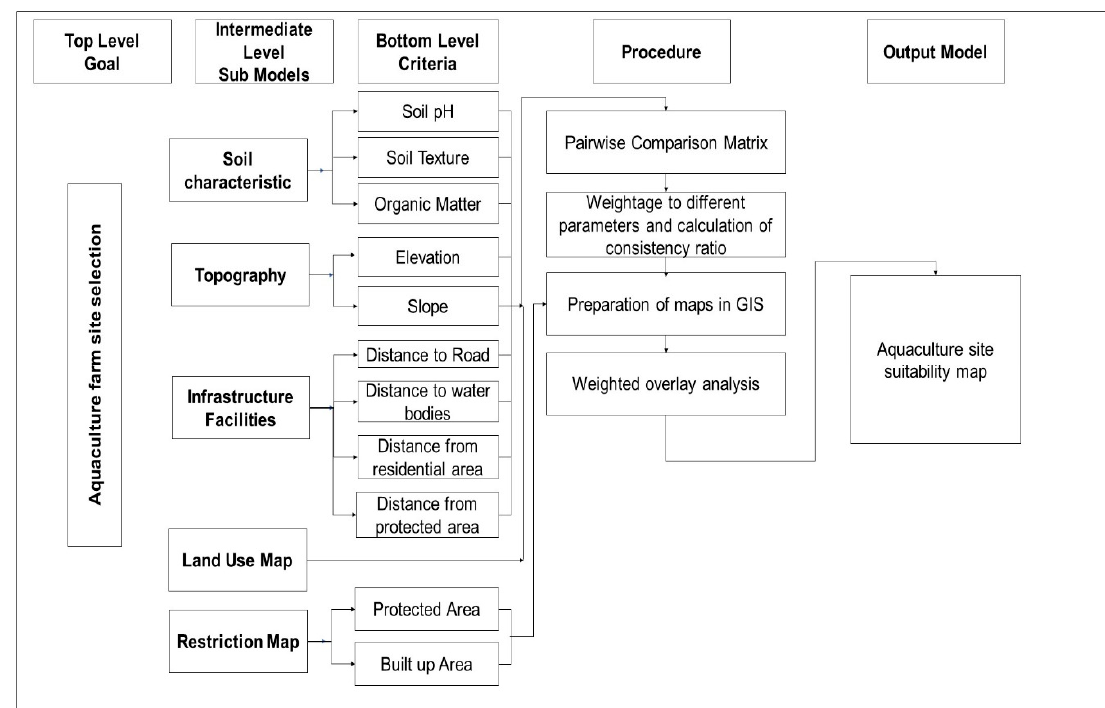
Figure 2. Schematic diagram of the modelling procedure for potential aquaculture farm sites.